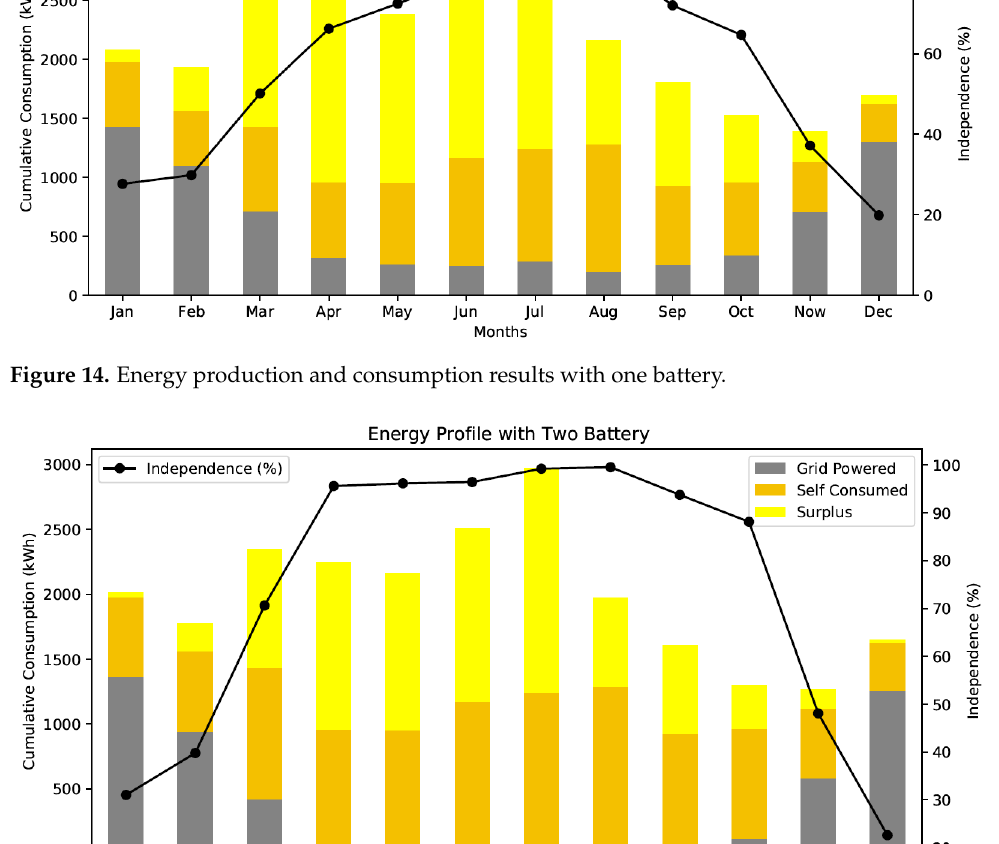
Figure 16. Annual self-sufficiency performance among different cases. 7.4. Cost-Benefit Analysis The main motivation of the optimisation study was to increase the earnings and reduce the depreciation costs of the system and thus make renewable energy systems more feasible for residential customers. The cost of benefit was compared for each case by making use of the earnings comparison formulas explained in the previous section. Figures 17–19 show the calculated monthly earnings of the three methodologies according to the different battery numbers.